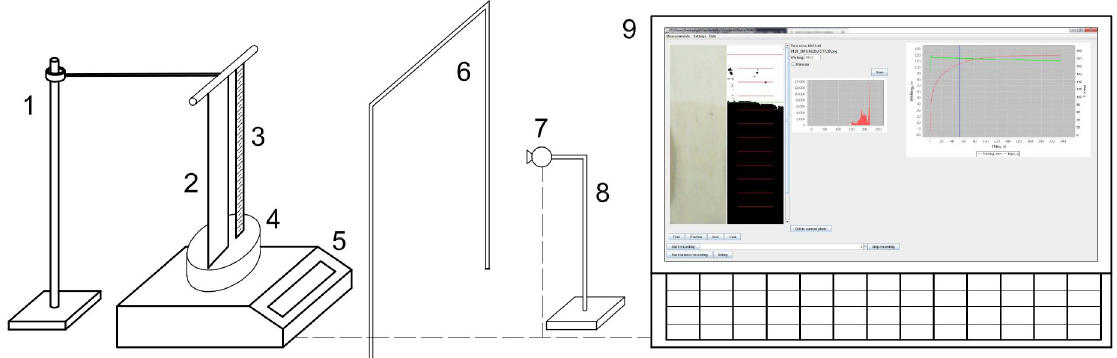
Fig 1. Scheme of the system for the determination of wicking, which includes 1. Sample holder, 2. Sample; 3. Ruler; 4. Dish with water, 5. Balance; 6. Lighting; 7. Camera; 8. Camera holder and 9. PC, with screen shot recorded during the measurement of wicking.